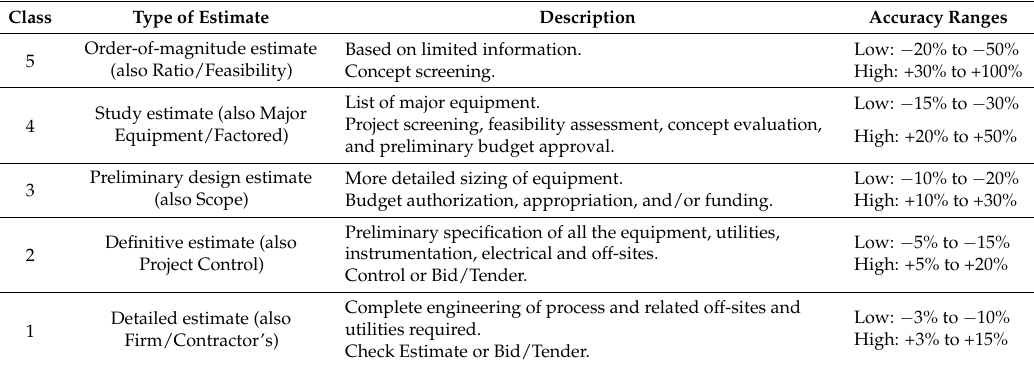
Table 1. Classification of capital cost estimates